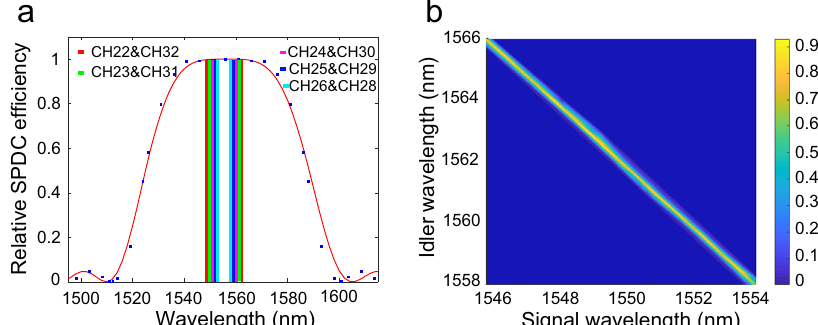
Fig. 2 Spectral characteristics of the SPDC source. a Spectrum of the SPDC source based on PPLN waveguide; the red curve is the theoretical result and the blue square points represent experimental data. The colorful bars indicate the time-energy entangled photon pairs multiplexed by 100-GHz DWDM channels. b Joint spectral amplitude of signal and idler fi lter with an extinction ratio of 180 dB. The second harmonic is used to generate photon pairs through the type-0 SPDC process in another 5-cm-long PPLN waveguide. Due to the photon energy conservation during the SPDC, the spectrum of the photon pairs is symmetric with respect to the central wavelength of 1555.75 nm and manifests strong frequency correlation, as shown by the SPDC spectrum and joint spectral amplitude in Fig. 2. To measure the joint spectral amplitude, a fi ber beam splitter and two tunable Bragg grating fi lters with a bandwidth of 0.07 nm are used to separate the signal and idler photons. The SPDC source spans a full width at half maximum of approximate 80 nm, covering the whole telecom C- and L-band. We use cascaded 100-GHZ dense wavelength division multiplexing (DWDM) fi lters to divert the signal and idler photons into 8 standard international telecom- munication union channels, i.e., CH22 to CH26 for signal and CH28 to CH32 for an idler.